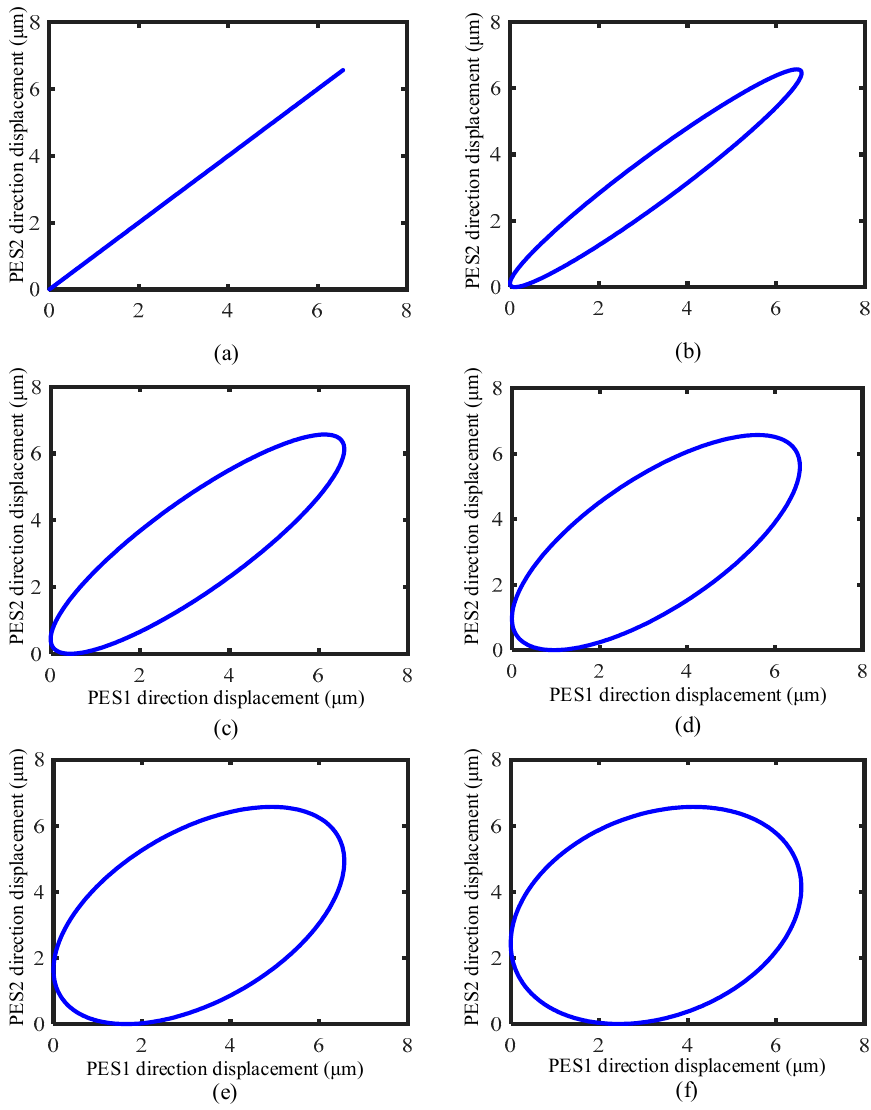
Figure 12. Theoretical motion trajectories of point P corresponding to different phase differences: ( a ) 0 ◦ , ( b ) 15 ◦ , ( c ) 30 ◦ , ( d ) 45 ◦ , ( e ) 60 ◦ , and ( f ) 75 ◦ .